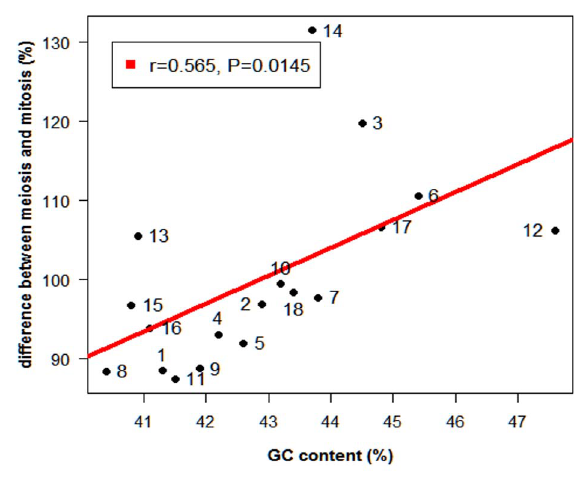
Figure 5. Relationship between the meiotic vs mitotic chromo- some length differences (y-axis) and the percentage of GC content (x-axis). The difference in relative length between meiotic and mitotic chromosomes is expressed as a percentage (% differ- ence=relative SC length/relative mitotic chromosome length 6 100). GC content of the porcine chromosomes was obtained from the porcine sequence 10.2 (http://www.ncbi.nlm.nih.gov/genome/ 84?project_id=28993).